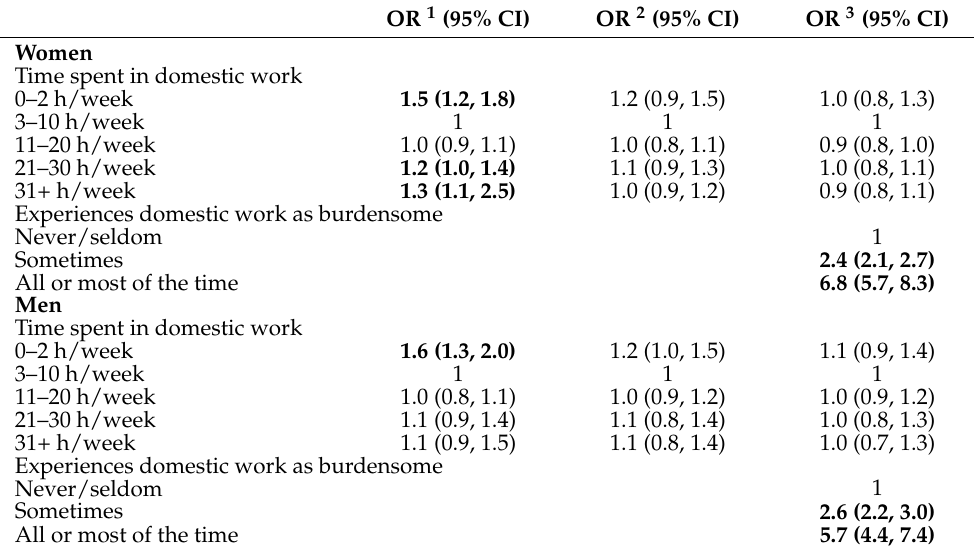
Table 2. Unadjusted and multivariate odds ratios (95% confidence intervals in parentheses) for depressive symptoms among women and men aged 30–69